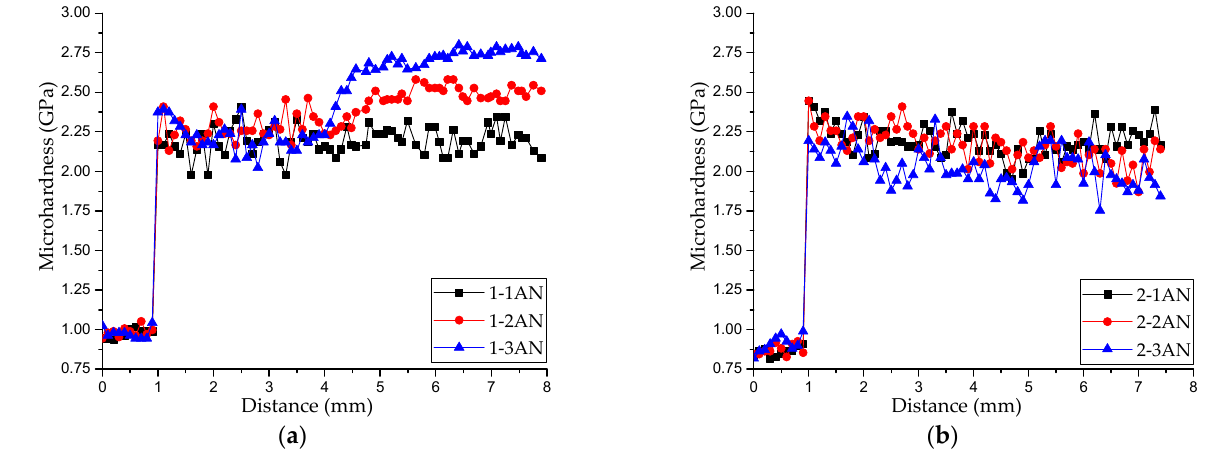
Figure 7. Distribution of the microhardness over the height of the annealed samples printed from Alloy 1 ( a ) and Alloy 2 ( b ).